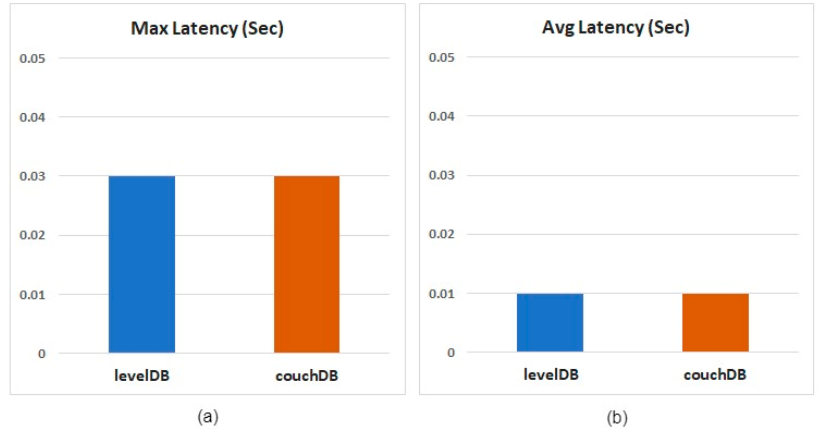
Figure 16. Latency results for single-data queries: ( a ) Maximum latency results, ( b ) Average latency results.